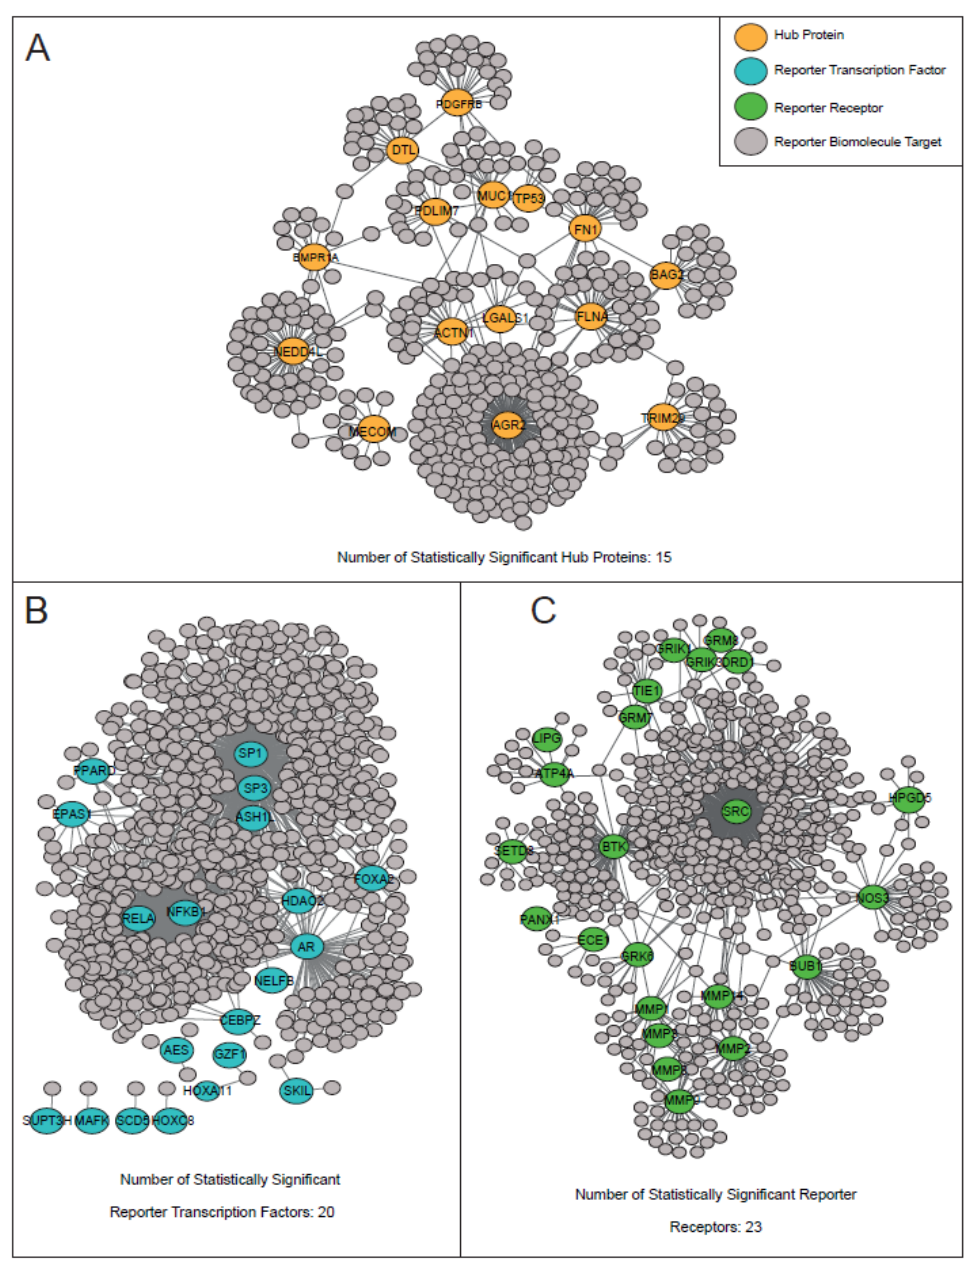
Figure 3. The reconstructed human biological networks. ( A ) The reconstructed protein–protein interaction (PPI) network. The revealed significant hub proteins according to employed topological parameters were shown in orange. ( B ) The reconstructed transcriptional regulatory interaction network. The statistically significant ( p -value < 0.001) reporter transcription factors (TFs) were shown in blue. (C) The reconstructed protein–receptor interaction network. The statistically significant ( p -value < 0.001) reporter receptors were shown in green.